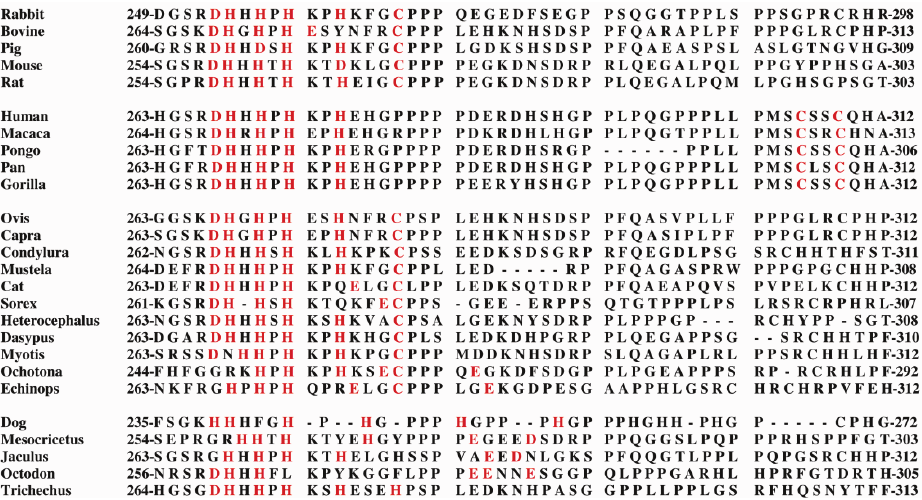
Figure 4. Comparison of the primary structure of HPRG from several mammalian species in the region localized between the N -terminal cystatin-like domains and the His-Pro-rich region. The marked amino acid residues are likely to be involved in the spatial formation of a specific zinc binding